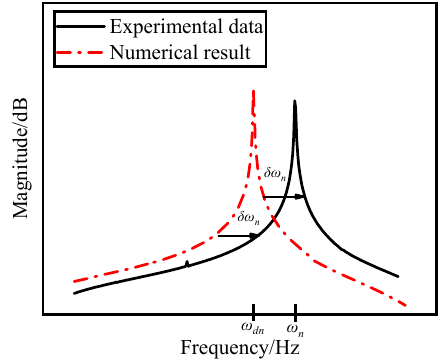
Figure 1. The frequency response function (FRF)’s of the real experimental model and the finite element (FE) model around the n th natural frequency.